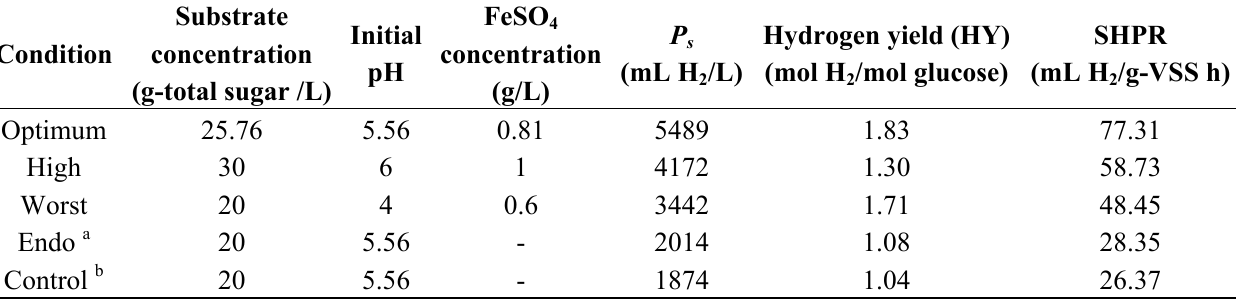
Table 5. Results and experimental design of confirmation